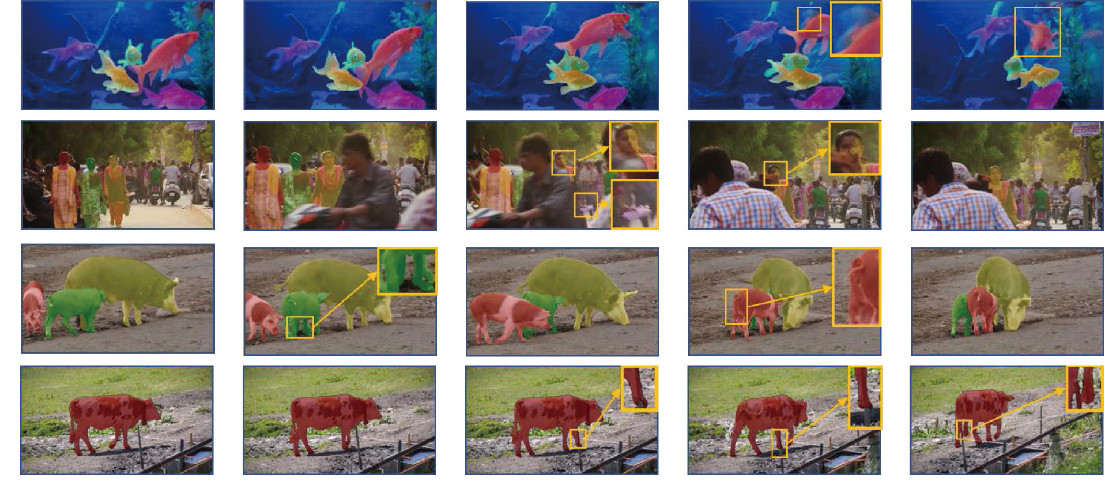
Fig. 10 Imperfect segmentation